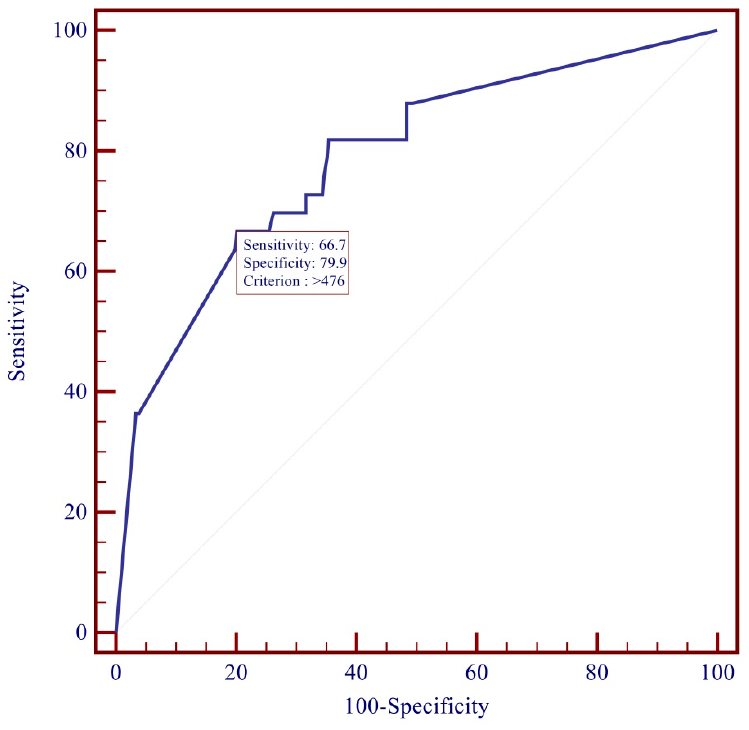
Figure 2. ROC curve for Beta-D-Glucan.